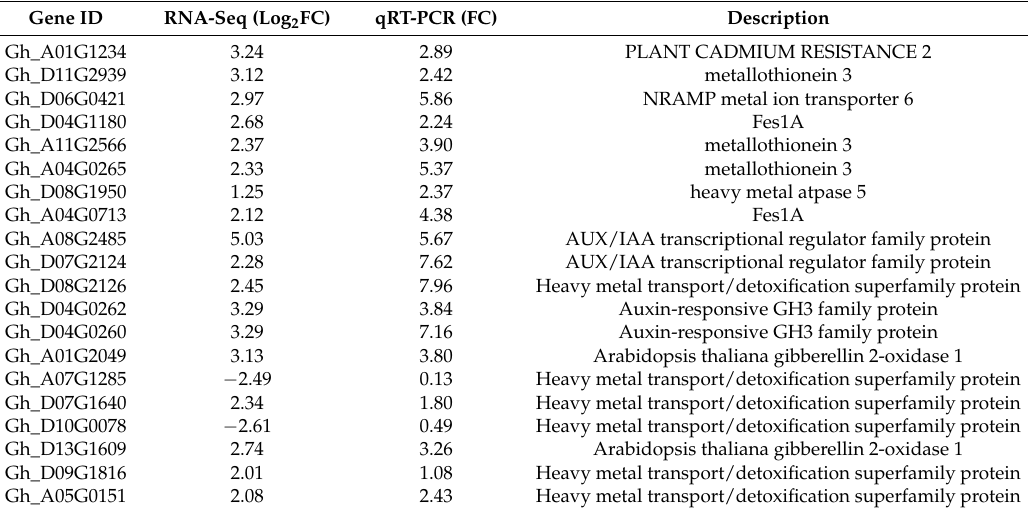
Table 2. The DEGs validated by qRT-PCR.